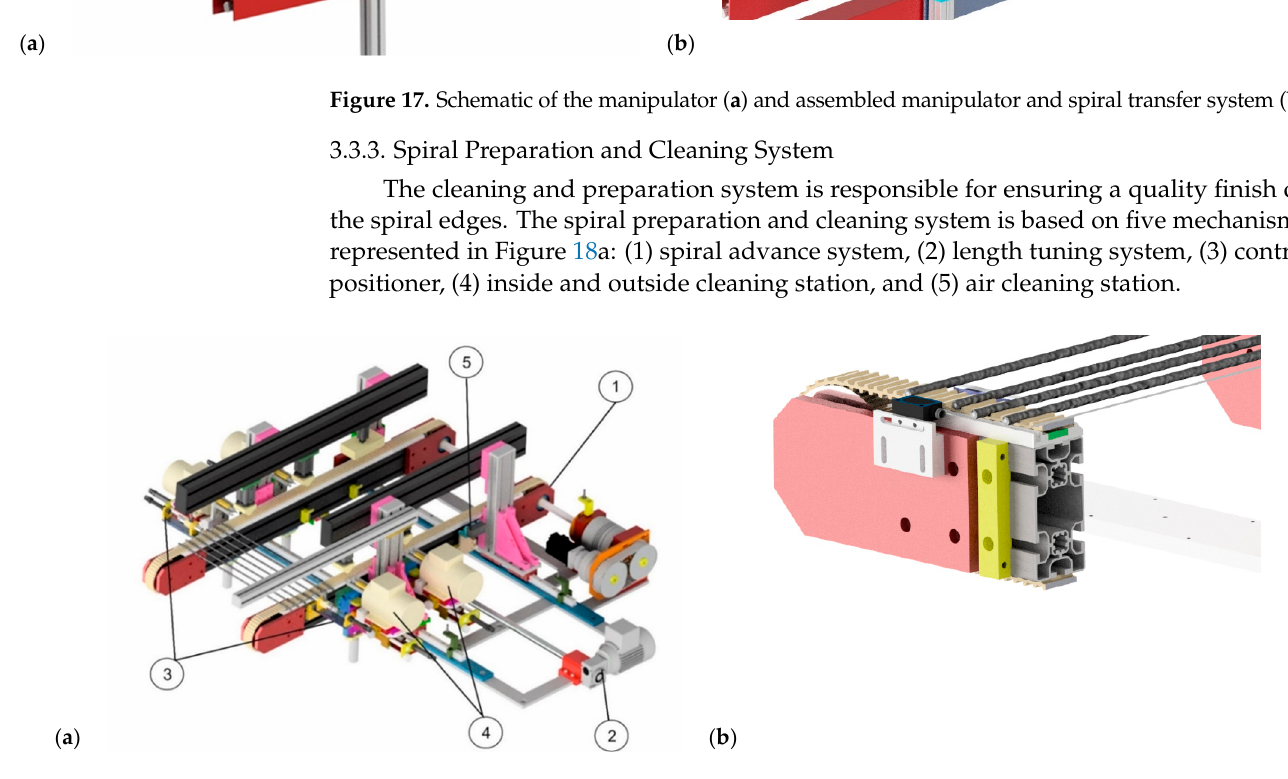
Figure 18. Spiral preparation and cleaning system ( a ) and magnet system and photelectric sensor ( b ).